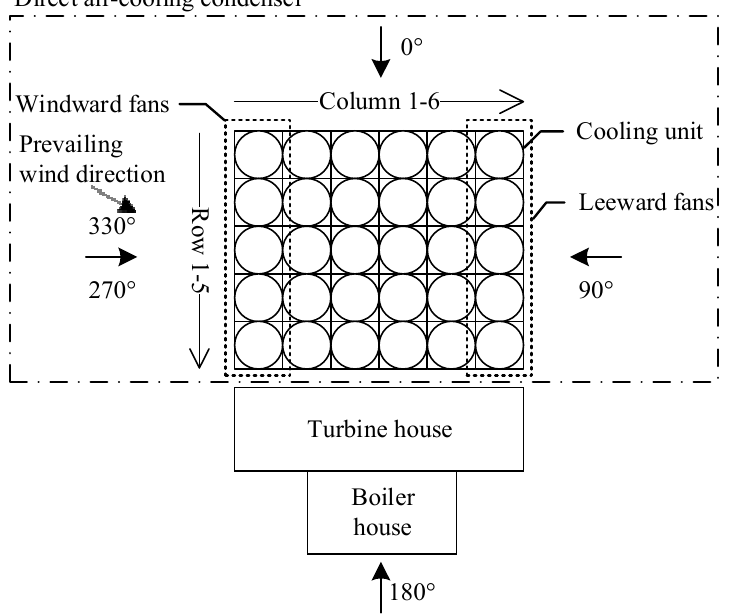
Figure 2. The planar layout of a direct air-cooling generating unit.